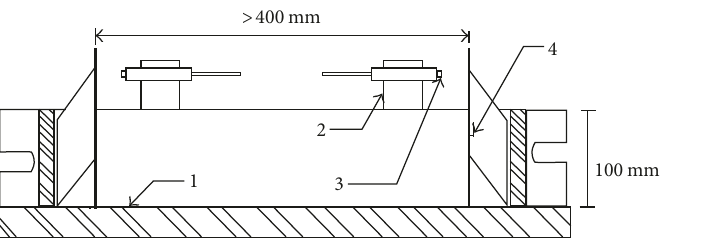
Figure 3: Noncontact concrete shrinkage deformation testing system. 1: steel mold; 2: sensor support; 3: displacement sensor; 4: standard